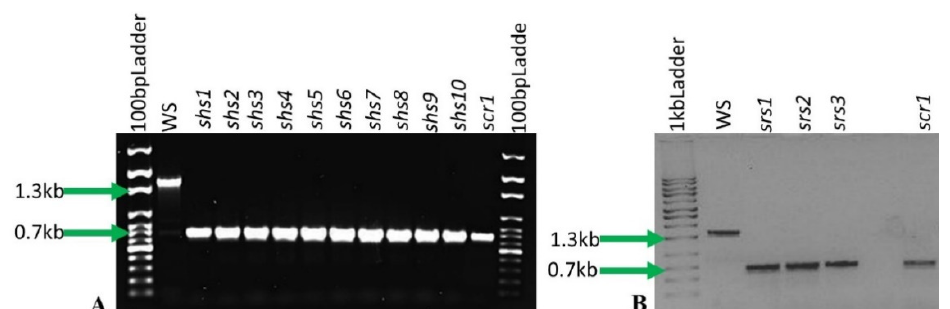
Figure 1. PCR amplification products in wild type, scr1 and suppressor lines to confirm the presence or absence of T-DNA insertion in the SCR gene in ( A ). Lane 1. 100 bp ladder; Lane 2. Wild Type WS (1.6 kb amplification products generated with SCR-F344 and SCR-R1954 primers); Lane 3–12. The scr hypocotyl gravitropic suppressors ( shs ), 1 to 10 (0.7 kb amplification products generated with T-DNA RBF and SCR-R1954 primers); Lane 13. scr1 (0.7 kb amplification products generated with T-DNA RBF and SCR-R1954 primers); Lane 14. 100 bp ladder. SCR-F344 and SCR-R1954 primers cannot amplify the scr1 allele because of the presence of large T-DNA insertion in the genomic region. Green arrows point to 1.3 kb and 0.7 kb marker bands. ( B ). Lane 1. 1 kb ladder; Lane 2. Wild Type WS (1.6 kb amplification products generated with SCR-F344 and SCR-R1954 primers); Lane 3–5. scr root length suppressors ( srs ), 1 to 3 (0.7 kb amplification products generated with T-DNA RBF and SCR-R1954 primers); Lane 6: scr1 (0.7 kb amplification products generated with T-DNA RBF and SCR-R1954 primers). Green arrows point to 1.3 kb and 0.7 kb marker bands.